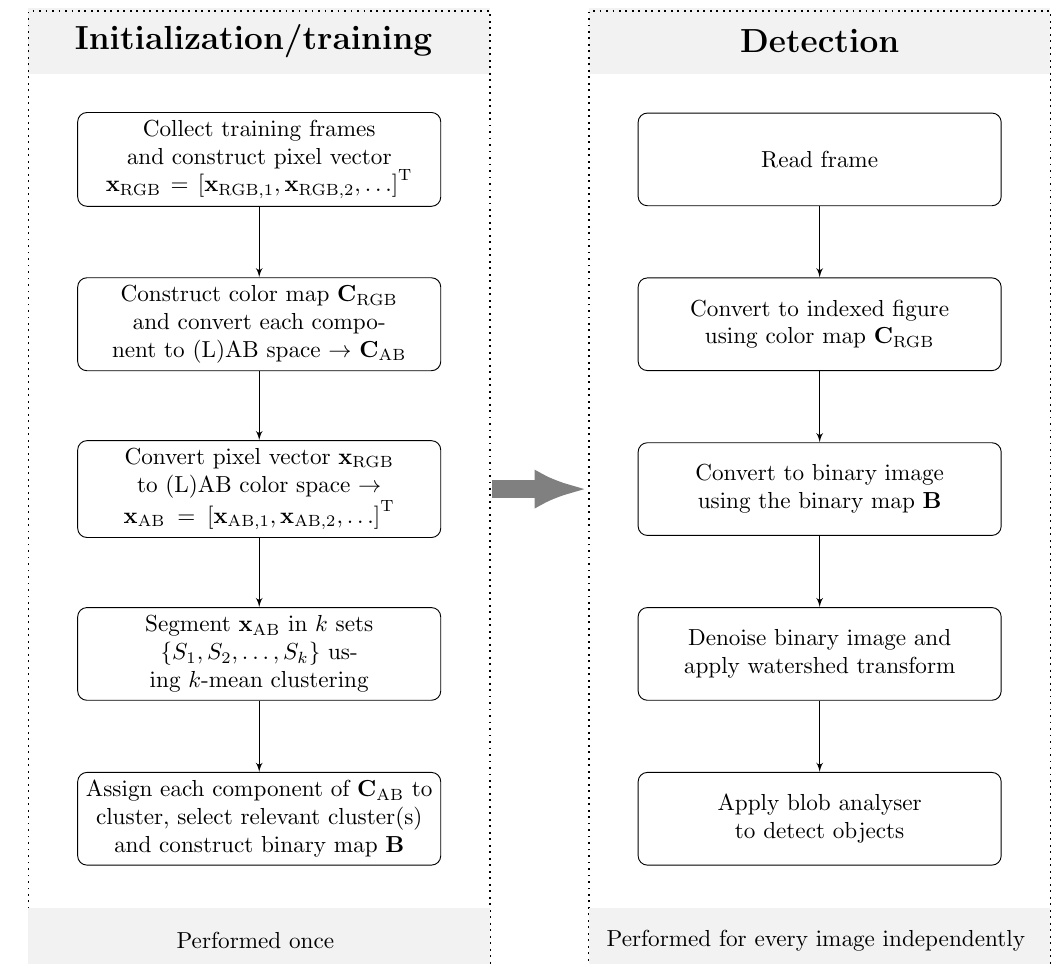
Figure 12. Flow chart for the detection of the